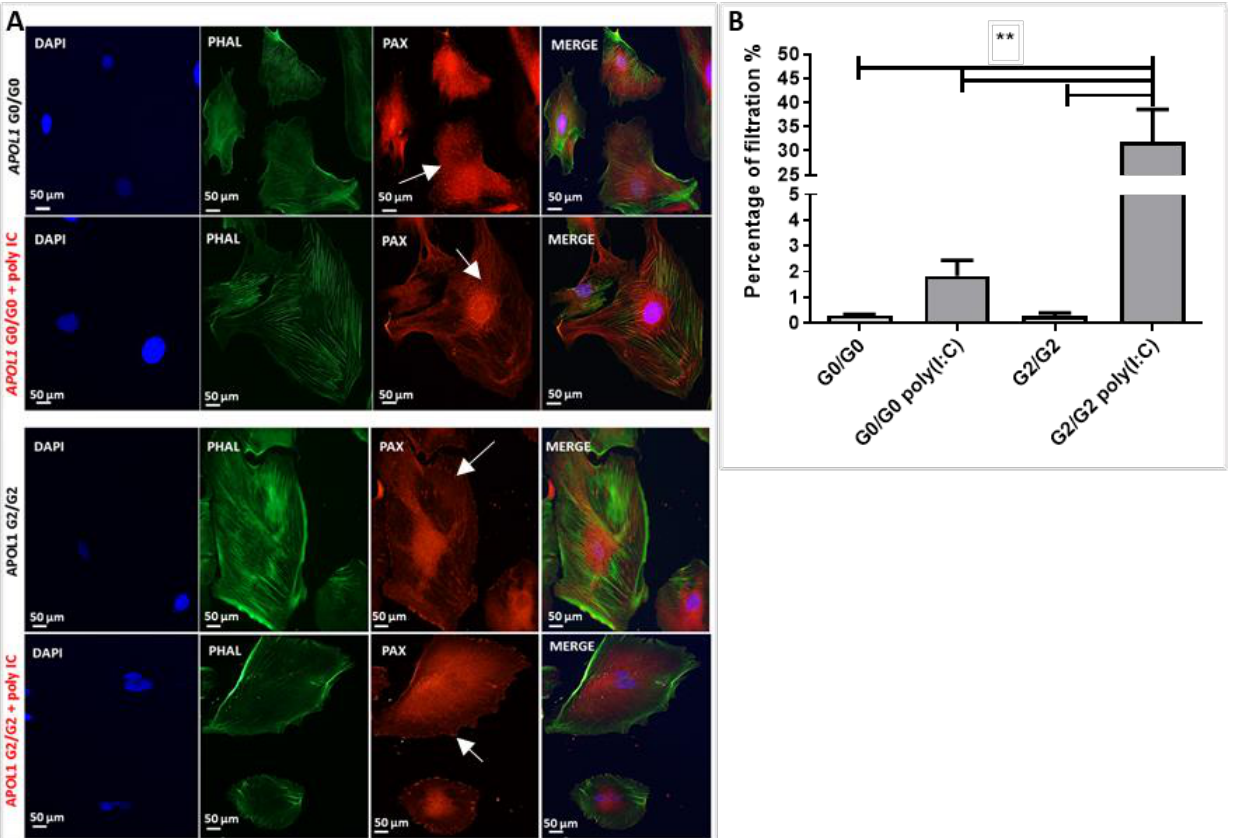
Figure 4. APOL1-induced cytoskeleton abnormalities. ( A ) Staining for actin filaments using phalloidin (phal) (green) and focal adhesion molecules using paxillin (pax) (red dots; arrows) and nuclear DAPI (blue) in APOL1 G0/G0 control cells and in APOL1 G2/G2 podocytes at basal conditions and after APOL1 induction by poly(I:C). ( B ) After 48 h of podocyte/GEC co-culture, the passage of FITC-BSA from the lower to the upper compartment was measured in the dynamic system during 3 h. APOL1 G2/G2 and G0/G0 podocyte cell lines showed similar permeability, which was significantly increased by poly(I:C) treatment only in the G2/G2 podocytes. Each bar represents mean ± SD of three independent experiments with three technical replicates for each cell line. ** p < 0.01.